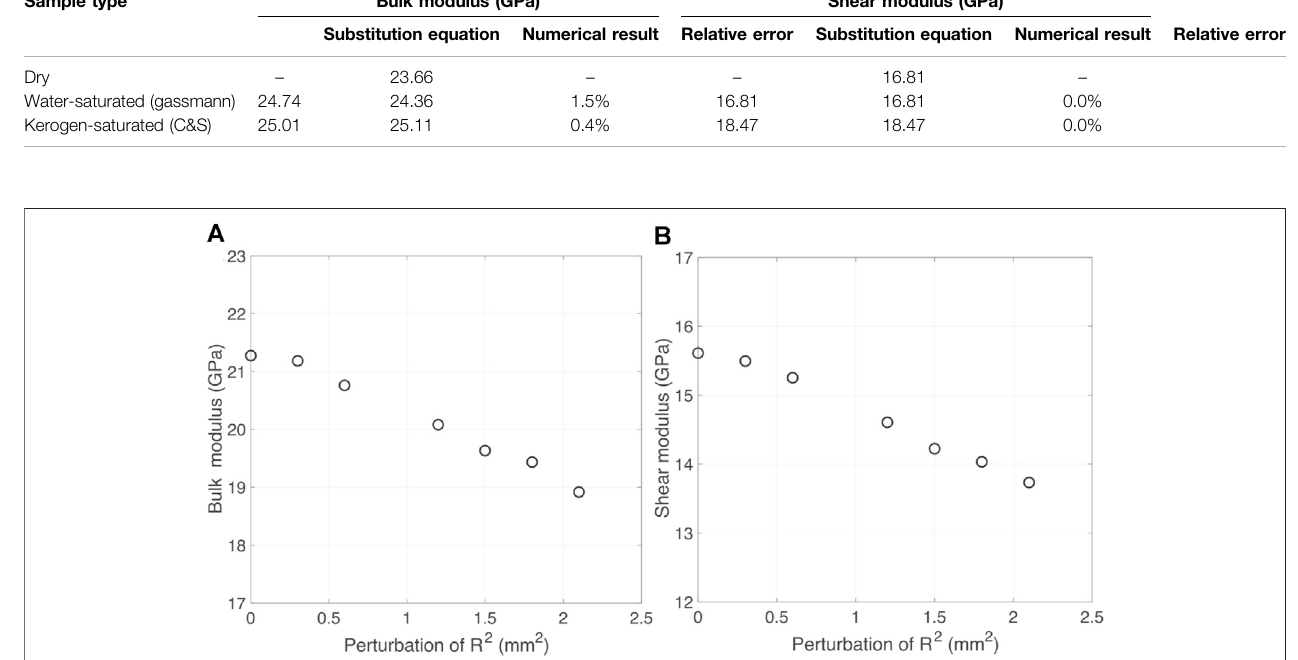
FIGURE6 | (A) thevariation ofbulk modulus ofdry samples vs. the perturbation of R 2 , (B) the variation ofshear modulus ofdry samples vs. the perturbation of R 2